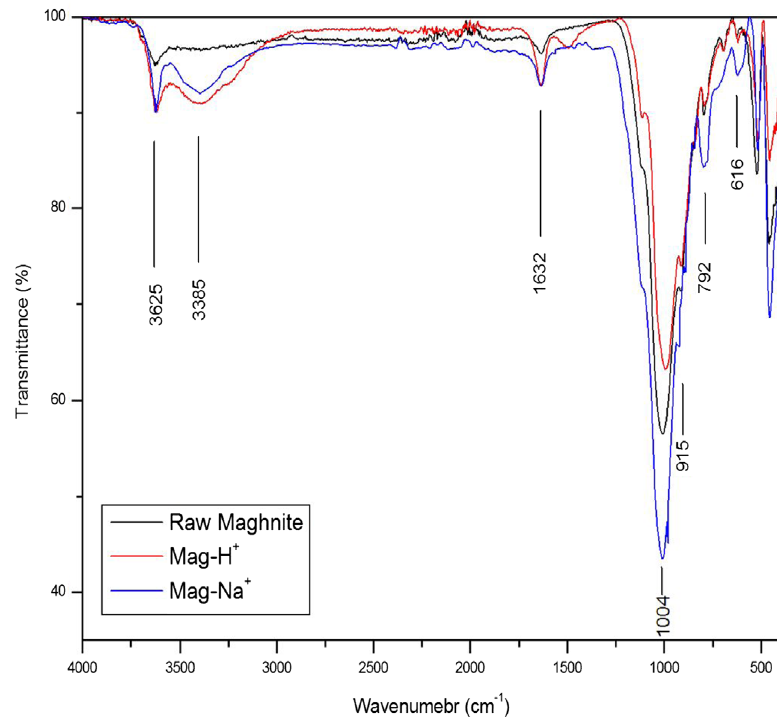
Figure 3: IR spectra of raw maghnite, maghnite sodium and acidic maghnite.